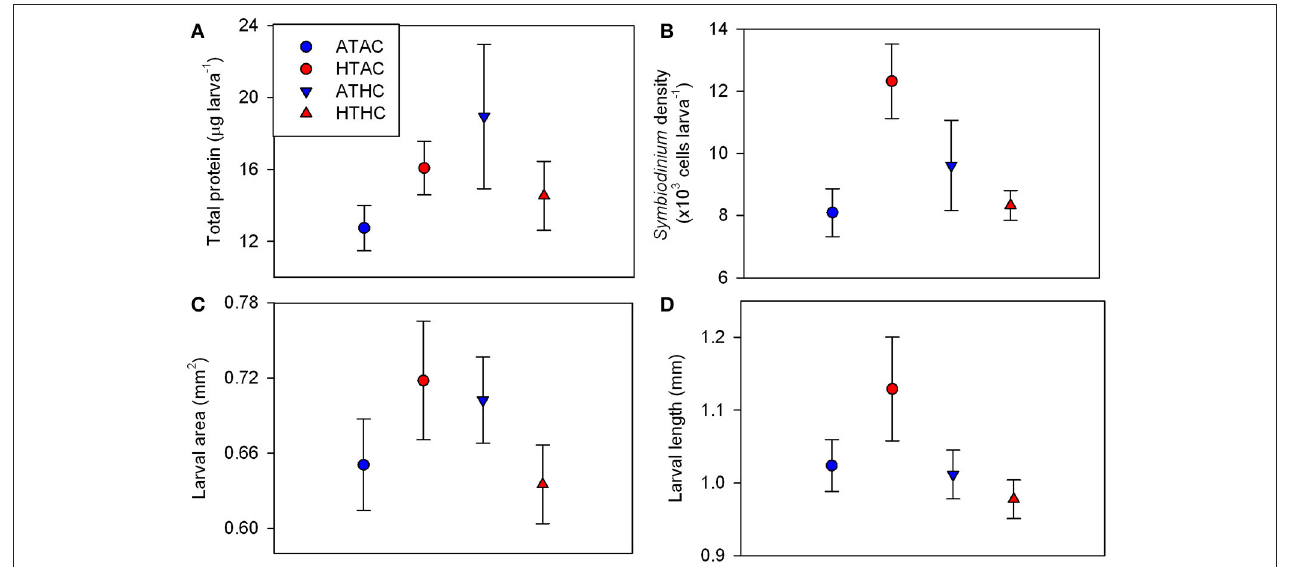
FIGURE 1 | Larval quality traits for Pocillopora damicornis larvae following 24-h exposures to pCO 2 and temperature. Mean ± SE changes in (A) total protein content ( n = 4), (B) Symbiodinium density ( n = 4), (C) larval area ( n = 20), and (D) larval length ( n = 20). Experimental treatments: Ambient-T, Ambient-pCO 2 (ATAC), High-T, Ambient-pCO 2 (HTAC), Ambient-T, High-pCO 2 (ATHC), High-T, High-pCO 2 (HTHC). Symbiont density was significantly affected by the interaction of pCO 2 and temperature ( X 2 = 5.081, df = 1, p = 0.034) as well as temperature alone ( X 2 = 5.248, df = 1, p = 0.022). Larval length was significantly affected by pCO 2 ( X 2 = 4.026, df = 1, p = 0.045). Refer to Table S3 for full statistical